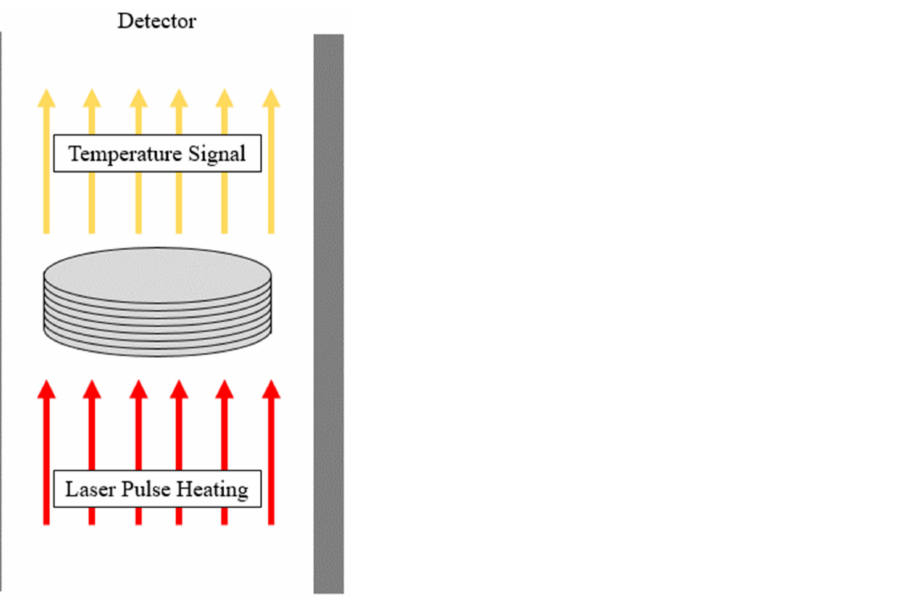
Figure 4. Schematic diagram of cross-plane thermal diffusivity measurement for laser flash apparatus.